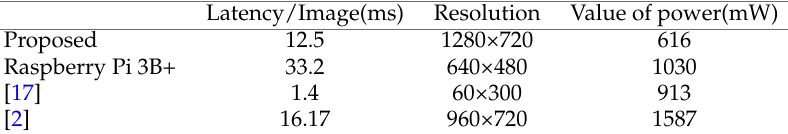
Table 8. Acceleration power